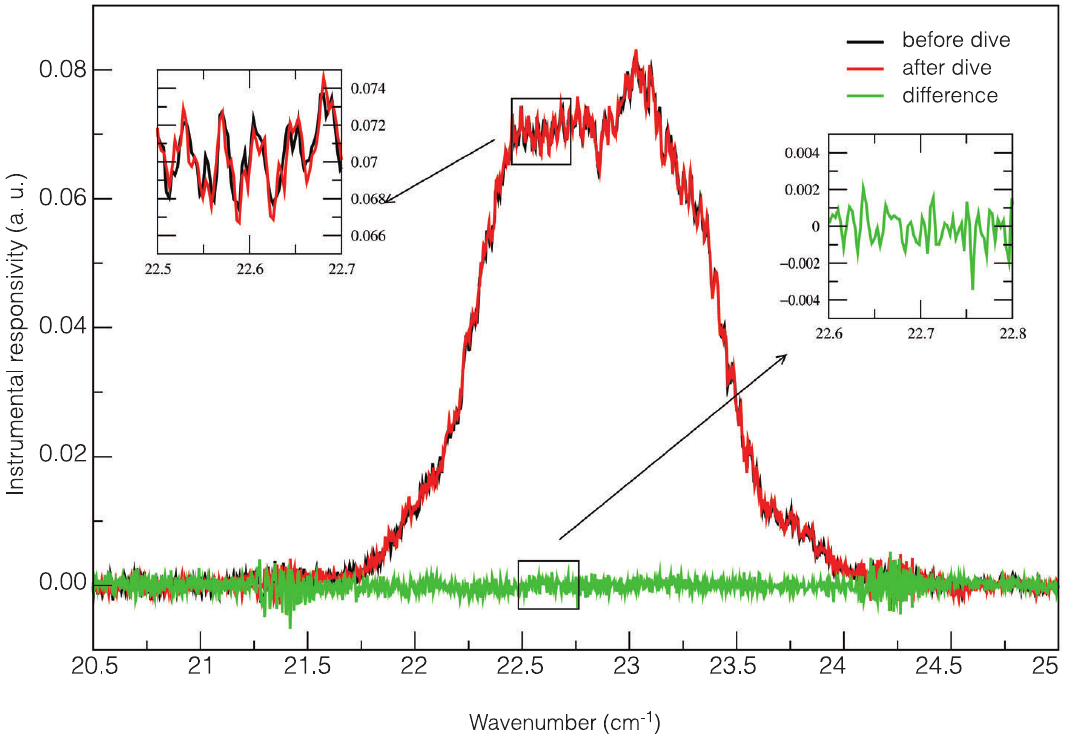
Fig. 12. Radiometric calibration stability of the SAFIRE-A spectrometer (fl ight 08.10.1999).